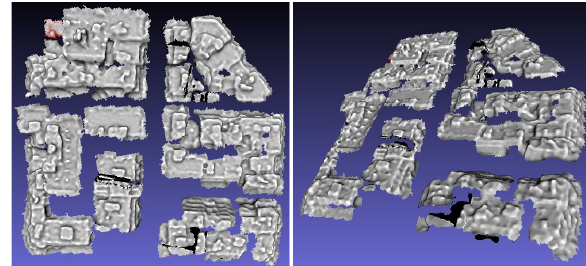
Figure 10. Screened Poisson Reconstruction of the tested area in MeshLab